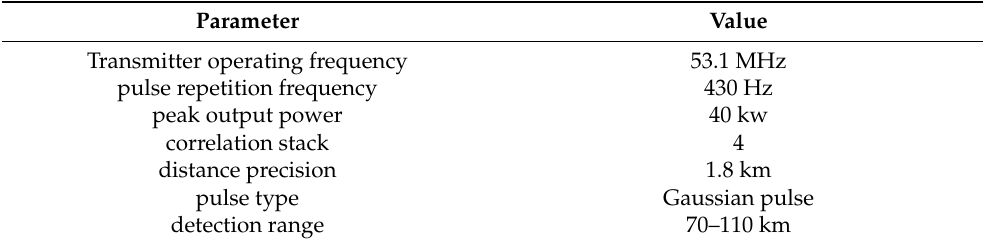
Table 1. The ST Kunming meteor radar main operating